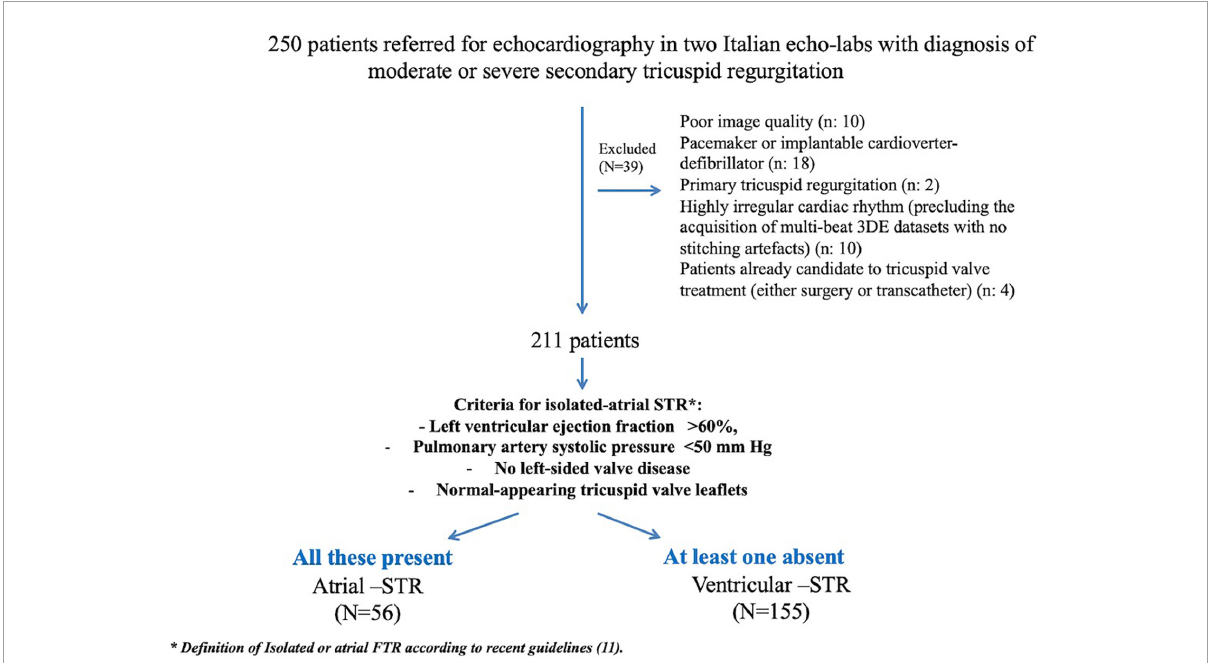
FIGURE2 Study flow-chart. 3DE, three-dimensional echocardiography; A-STR, atrial secondary tricuspid regurgitation; RV, right ventricular; V-STR, ventricular secondary tricuspid regurgitation.